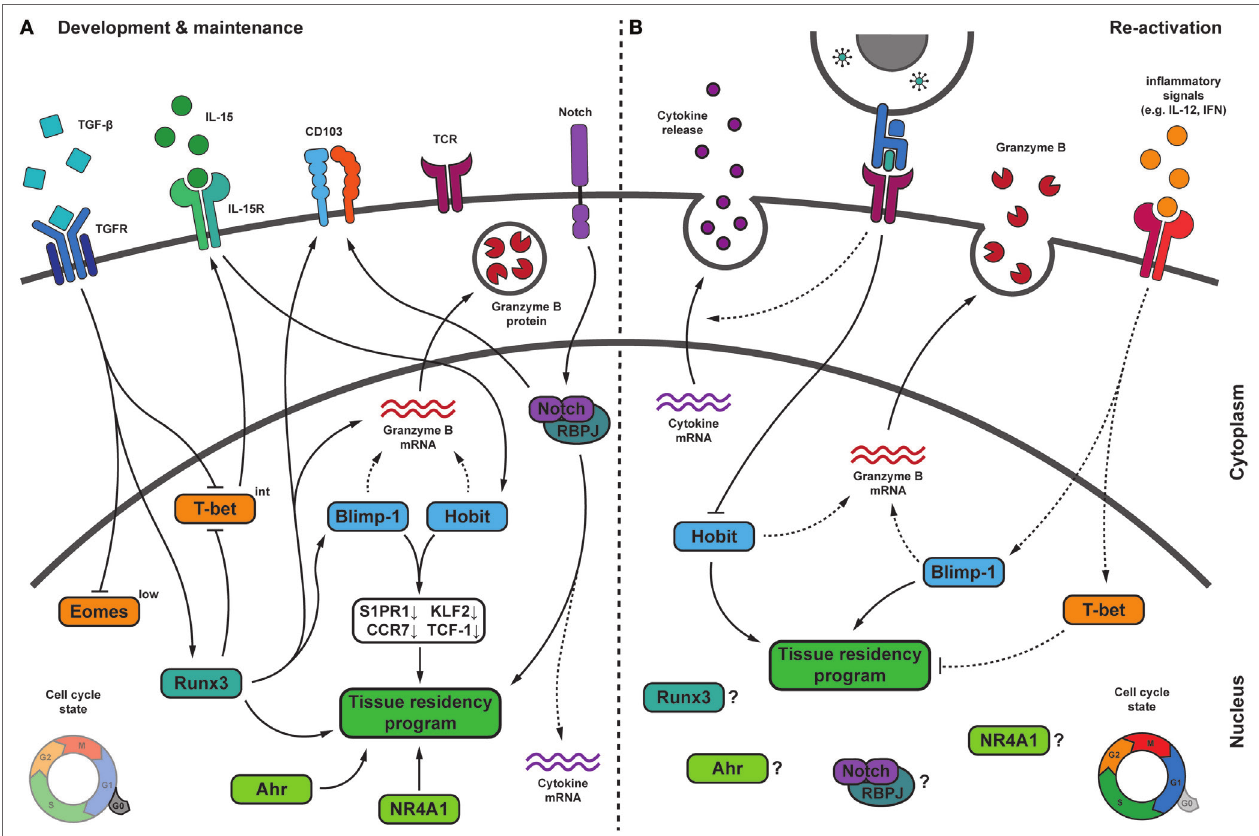
FigURe 3 | Transcriptional regulation of T RM cells during development, maintenance, and upon pathogen re-challenge. (A) During their formation, T RM cells receive multiple signals from the tissue microenvironment that integrate into a transcriptional program, which drives T RM differentiation and maintenance. In several tissues, transforming growth factor β (TGF- β ) signaling drives the downregulation of the T-box transcription factors Eomesodermin (Eomes) and T-bet. Residual T-bet expression is required for IL-15R β expression. The transcription factor homolog of Blimp-1 in T cells (Hobit) can be induced in an IL-15-dependent manner and, together with its homolog Blimp-1, represses the expression of S1PR1, CCR7, Kr ϋ pple-like factor 2 (KLF2), and TCF-1, which is crucial for tissue residency. Blimp-1 and Hobit may also contribute to granzyme B maintenance in T RM cells. The transcription factor Runx3, which can be induced by TGF- β signaling, is crucial for the establishment and maintenance of many aspects of T RM cells, including granzyme B and CD103 expression. Runx3 has been shown to induce Blimp-1. Notch may regulate expression of the adhesion molecule CD103, is essential for maintenance of T RM cells and might contribute to the elevated transcript levels encoding for pro-inflammatory cytokines in T RM cells. Other factors regulating T RM cells include the nuclear receptor NR4A1, and the aryl hydrocarbon receptor (AhR). During quiescence, T RM cells show low proliferative activity. (B) Following pathogen re-encounter, T RM cells are exposed to antigen-dependent T cell receptor (TCR) triggering and a variety of inflammatory signals. TCR triggering in T RM cells may result in downregulation of Hobit, thereby weakening its contribution to maintenance of tissue residency. Inflammatory signals, such as IL-12 and type I interferons (IFN), can induce expression of Blimp-1 and T-bet. While increased Blimp-1 expression might fortify T RM features, elevated levels of T-bet could interfere with tissue residency. T RM cells rapidly release pro-inflammatory cytokines upon reactivation in an antigen-dependent manner. Upon re-infection, T RM cells undergo local proliferation. Dashed lines indicate relations that require further investigation. Abbreviations: Blimp-1, homolog of B lymphocyte-induced maturation protein 1; IL, interleukin; S1PR1, sphingosine-1-phosphate receptor 1; CCR7, C-C chemokine receptor type 7; TCF-1, T cell factor 1; Runx3, Runt-related transcription factor 3; RBPJ, recombining binding protein suppressor of hairless; NR4A1, nuclear receptor subfamily 4 group A